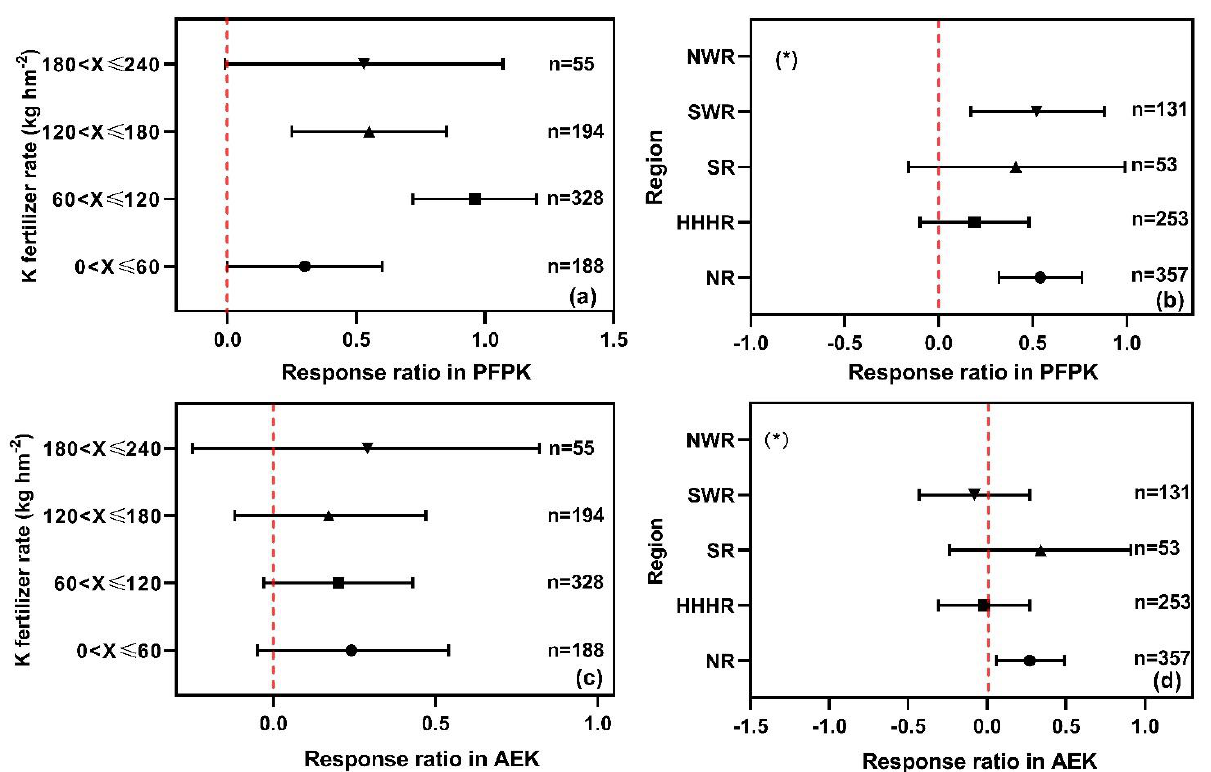
Figure 13. The effects of period (2012 − 2018 versus 2005 − 2011) on maize PFPK and AEK at each K fertilization level ( a , c ), in each region ( b , d ). NR: Northern region; HHHR: Huang − Huai − Hai region; SR: Southern region; SWR: Southwest region; NWR: Northwest region; PFPK: partial factor productivity of K; AEK: agronomic efficiency of K. The error lines indicate the 95th percentile bootstrap confidence intervals, whereas n values indicate the corresponding number of observations (total number of control and treatment values). The PFPK and AEK values of the 2012–2018 period were the treatment values, whereas the PFPK and AEK values of the 2005 – 2011 period were the control values. * means PFPK and AEK analyses were not performed due to insufficient